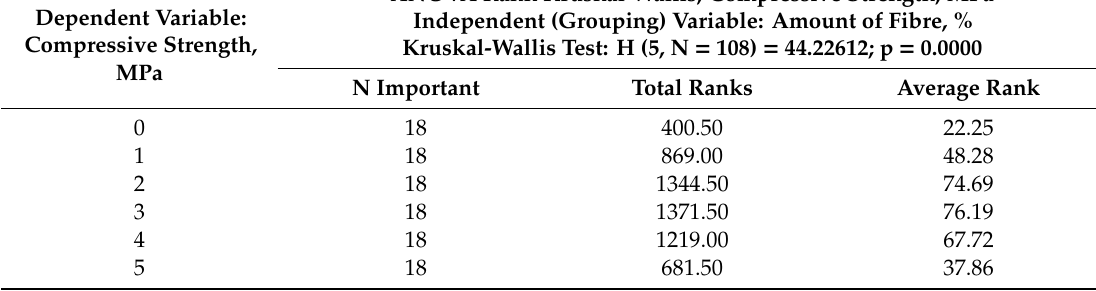
Table 12. Results of the Kruskal-Wallis ANOVA rank test of compressive strength related to fibre content. Dependent